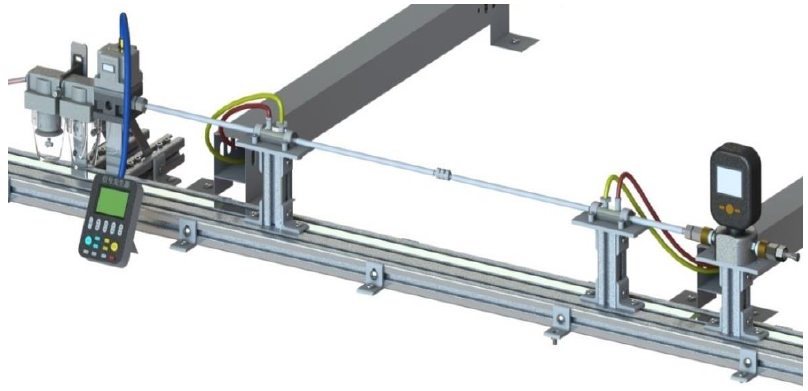
Figure 3. Mechanical experiment layout.